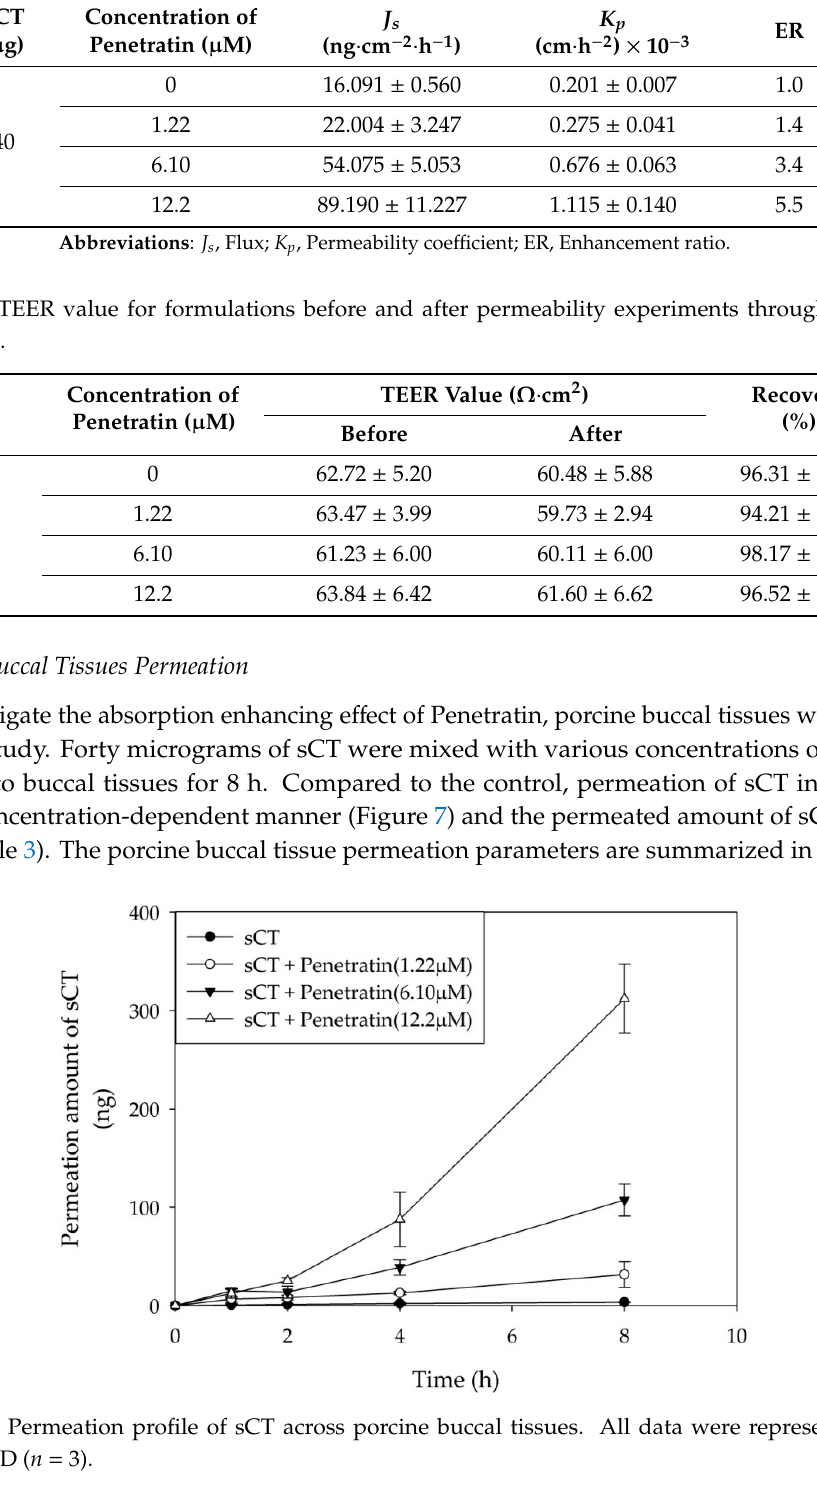
Table 1. Permeation parameters calculated from the TR146 cell permeation study.